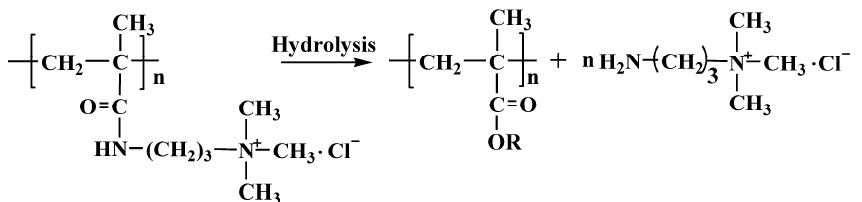
Figure 1. Schematic diagram of possible hydrolysis of PMAPTAC.